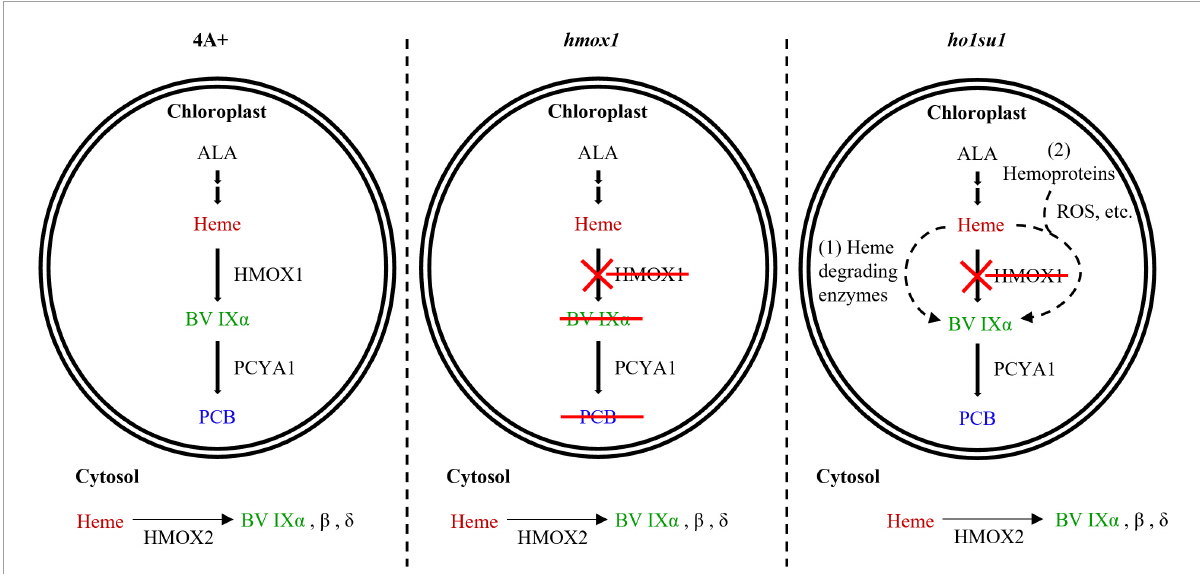
FIGURE6 Model for bilin biosynthesis in ho1su1 . In wild-type 4A+, heme is catabolized by HMOX1 and PCYA1 to yield BV IX α and PCB, respectively (left). In hmox1 , BV IX α and PCB are not synthesized in the chloroplast due to the disruption of HMOX1 , although PCYA1 still accumulates (middle). The cytosolic BV IX α produced by overexpressing HMOX2 or truncated HMOX1 is insufficient to support bilin biosynthesis in the chloroplast of hmox1 . In ho1su1 , PCB is produced in the absence of HMOX1 (right). Alternative pathways for bilin biosynthesis in ho1su1 may include (1) the conversion of heme to BV IX α by unknown heme degrading enzymes and (2) reactive oxygen species (ROS) or other metabolites (e.g., ascorbic acid) attacking heme or hemoproteins to produce BV IX α . ALA, 5-aminolevulinic